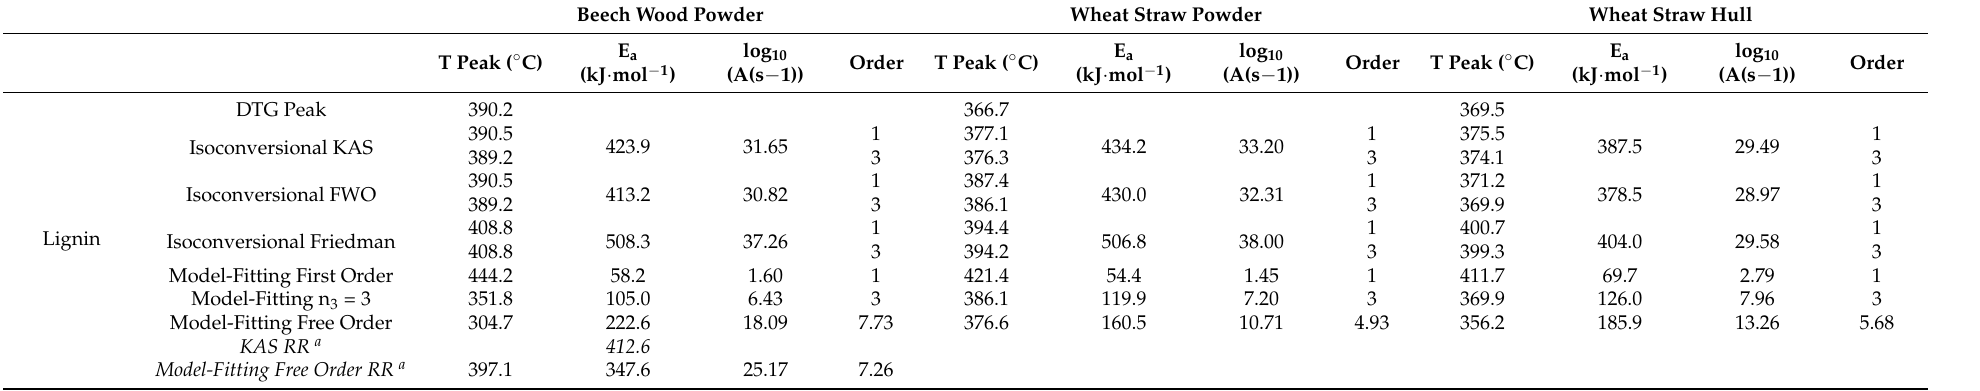
Table 10. Peak values and kinetic parameters for the different feedstocks and different methods. Lignin peak @ 10 K · min − 1 . Beech Wood